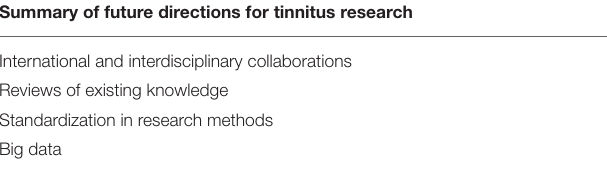
TABLE 3 | Common objectives identified across different domains of tinnitus research as summarized in Table 2